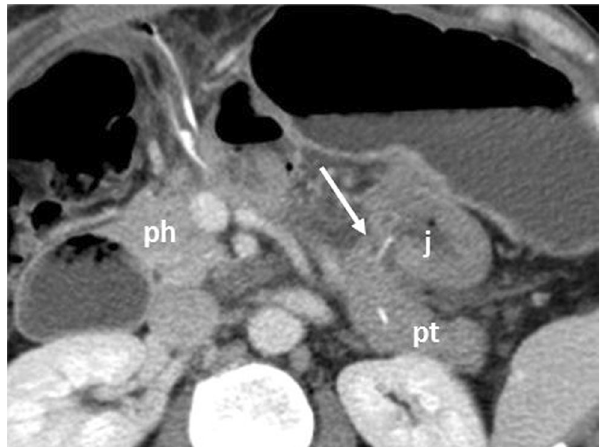
Fig. 5 Pancreaticojejunostomy. The pancreas (p), jejunal anastomotic loop (j) and pancreaticojejunostomy (white arrow) are visible after a Whipple procedure